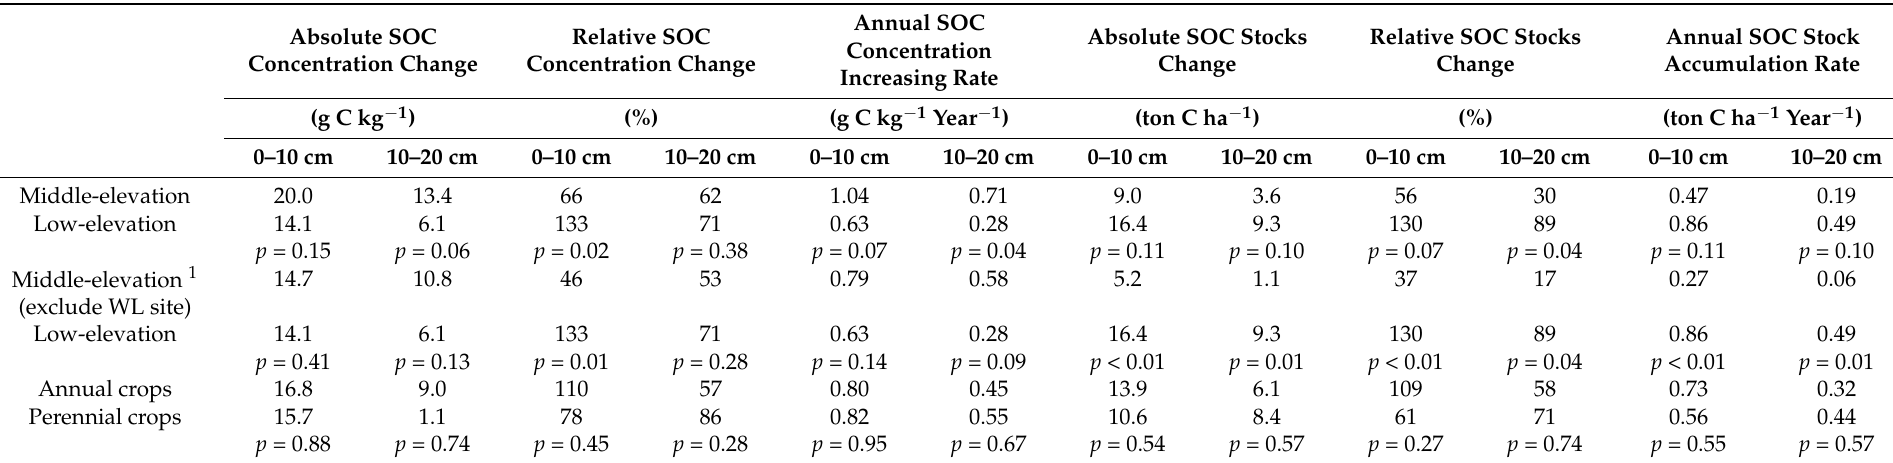
Table 4. Differences in absolute change, relative change, and annual accumulation rate of soil organic carbon (SOC) concentrations and stocks between low-elevation and middle-elevation sites and between annual crop and perennial crop